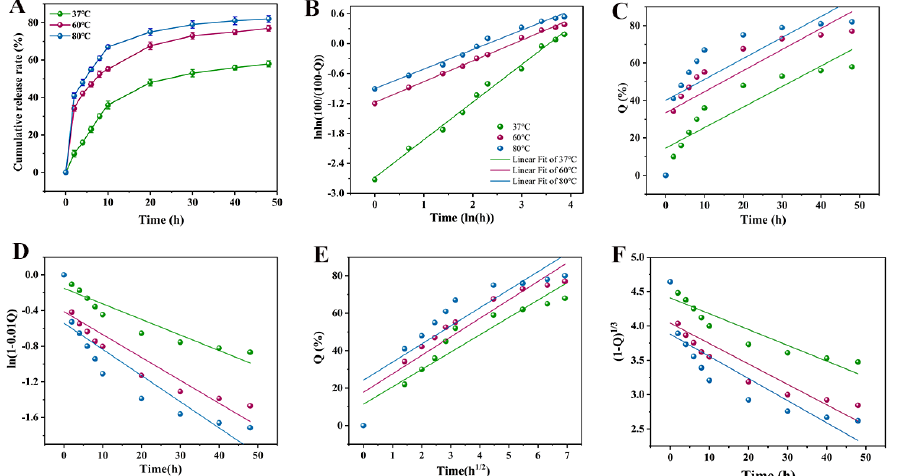
Figure 4 . ( A ) In vitro release profile of AVAs 2f from FMIPs, ( B ) Weibull kinetic release model, ( C ) Firet kinetic release model, ( D ) Higuchi kinetic release model, ( E ) Zero kinetic release model, and ( F ) Hixcon − Crowell kinetic release model of FMIPs at 37, 60, and 80 °C .